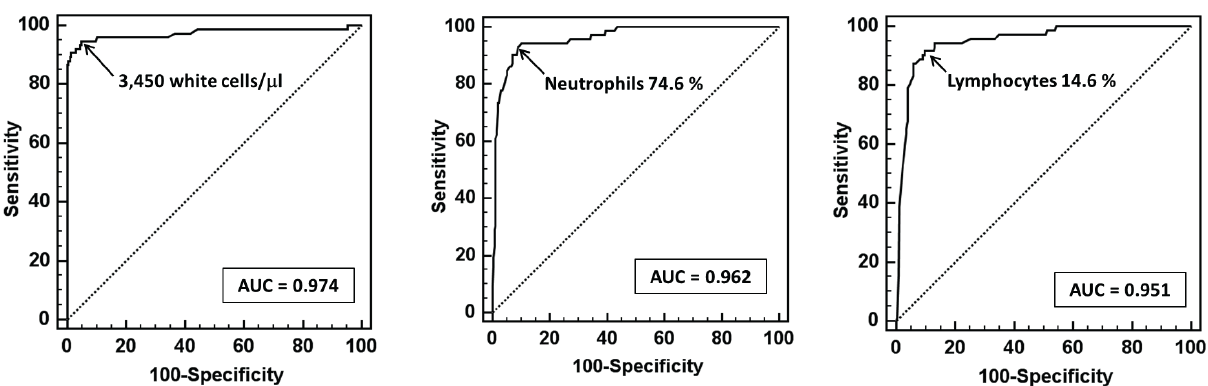
Fig. 2. Receiver operating characteristic (ROC) curves for a) the synovial white cell count; b) neutrophil percentage; and c) lym- phocyte percentage. The diagonal dashed line is the line of non-discrimination. The larger the area under the curve, the higher the sensitivity and specificity, and thus the power of the diagnostic test. AUC = area under the curve. Table 3. Diagnostic characteristics for the SWCC, percentage of neutrophils and percentage of lymphocytes for all the groups and for THRs or TKRs separately.